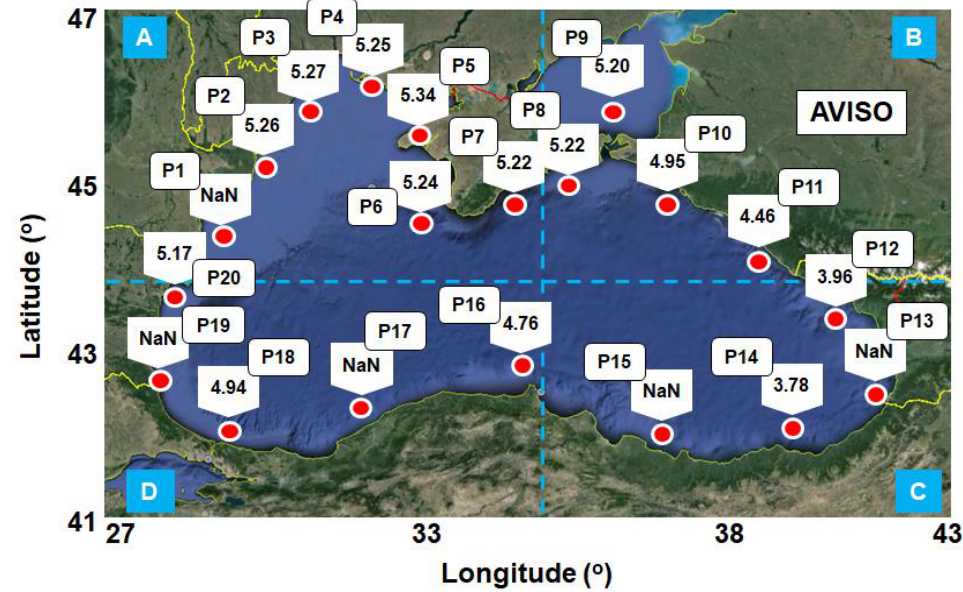
Figure 10. U 80 average values reported by the AVISO measurements (September 2009–September 2017).